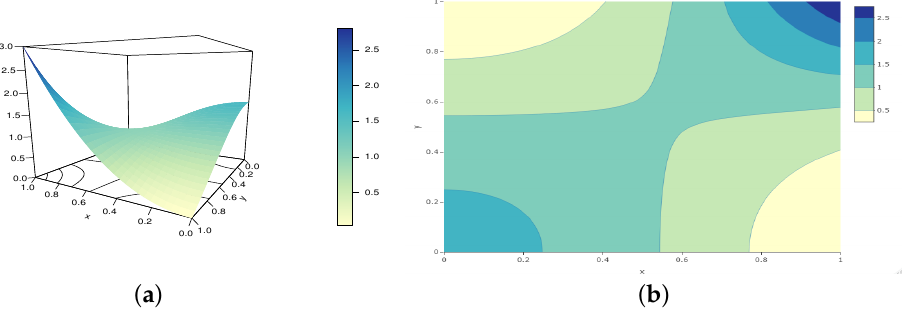
Figure 4. Illustrations of the ( a ) perspective plot and ( b ) contour plot of the GCC copula density for the following configuration: a = 1/2 and b = c = 2, belonging to Configuration 1.